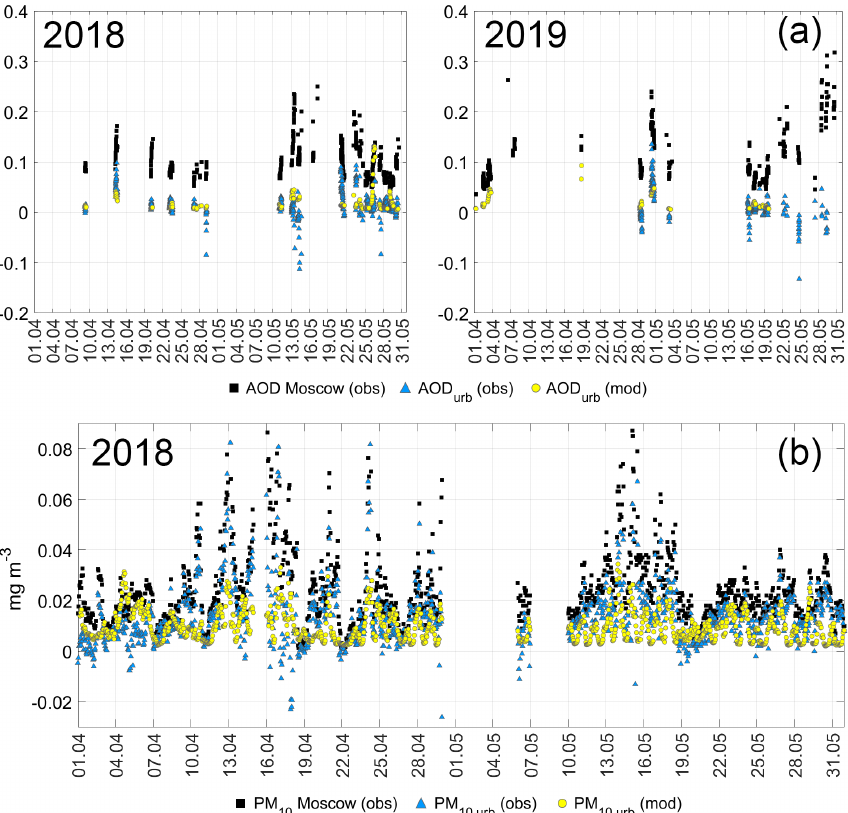
Figure 9. (a) Time series of AOD550 from observations, AOD Moscow (obs), and its urban components from observations, AODurb (obs), and modeling, AODurb (mod), in 2018 (left upper panel) and 2019 (right upper panel). (b) Time series of PM 10 from observations (PM 10 Moscow (obs), mgm − 3 ) and its urban components (mgm − 3 ) from observations, PM 10urb (obs), and modeling, PM 10urb (mod).